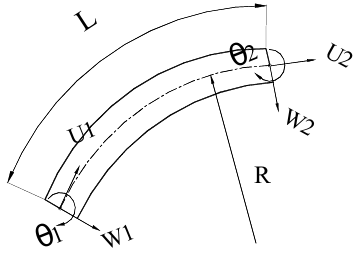
Fig. 3. Nodal displacement at 3-node circular arch